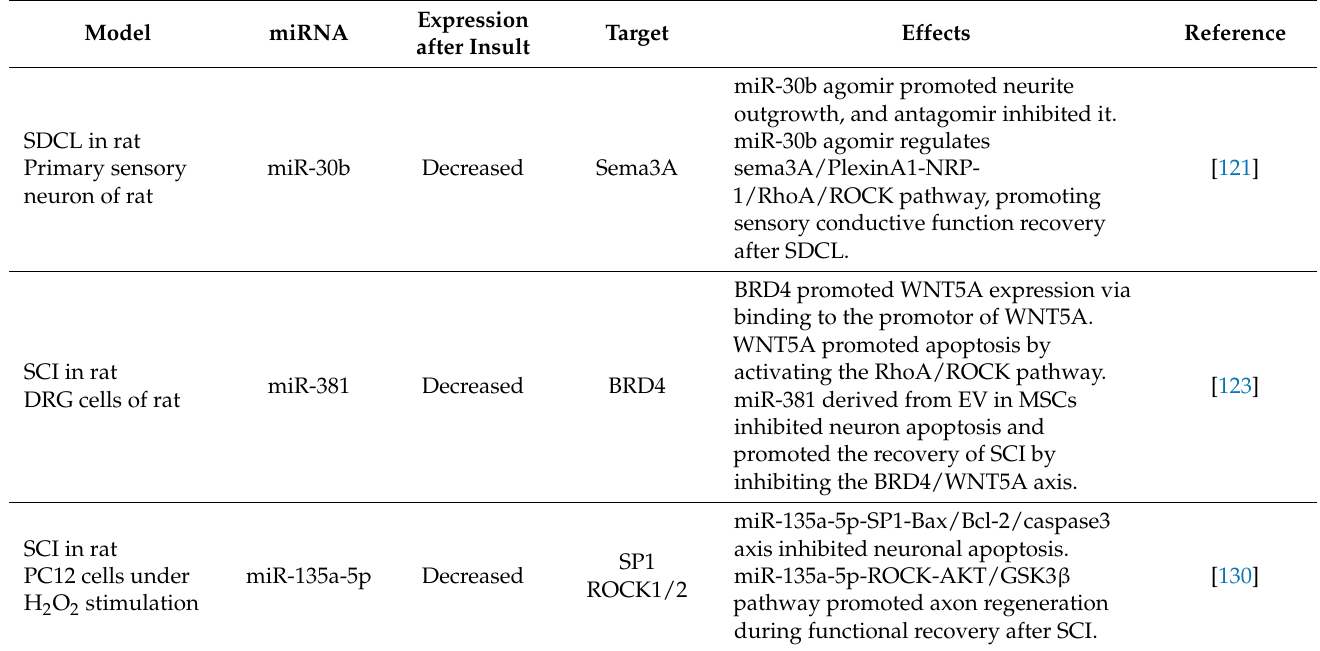
Table 2. MiRNAs and the Rho/ROCK pathway in